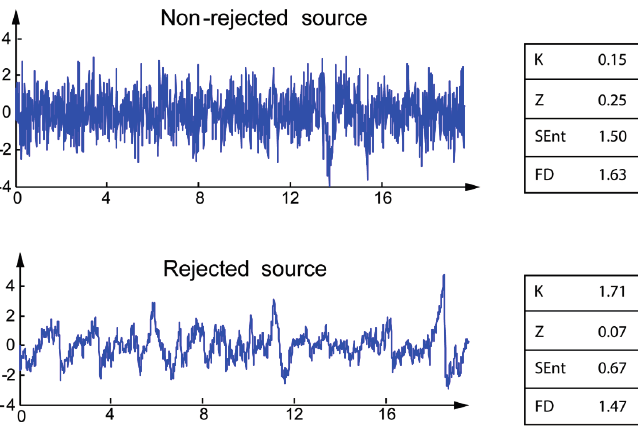
Figure 1. Illustration of the four markers for non-rejected ( top ) and rejected ( bottom )